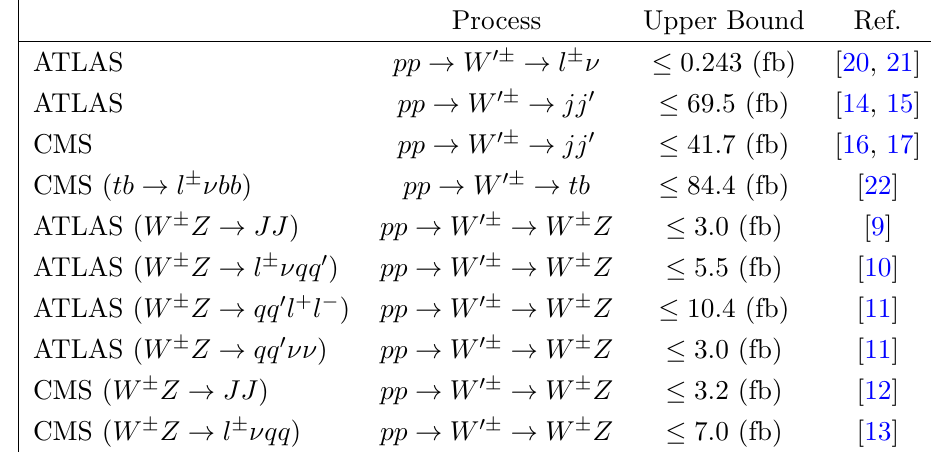
Table 2 . Di(cid:11)erent decay mode searches at 13 TeV of W 0 with m W 0 (cid:24) 3 TeV for both ATLAS and CMS constraints. Here j includes all light (cid:13)avors, l and (cid:23) include ( e; (cid:22) ) and ( (cid:23) e ; (cid:23) (cid:22) ), separately. Finally, J means large- R jets ( W jet or Z